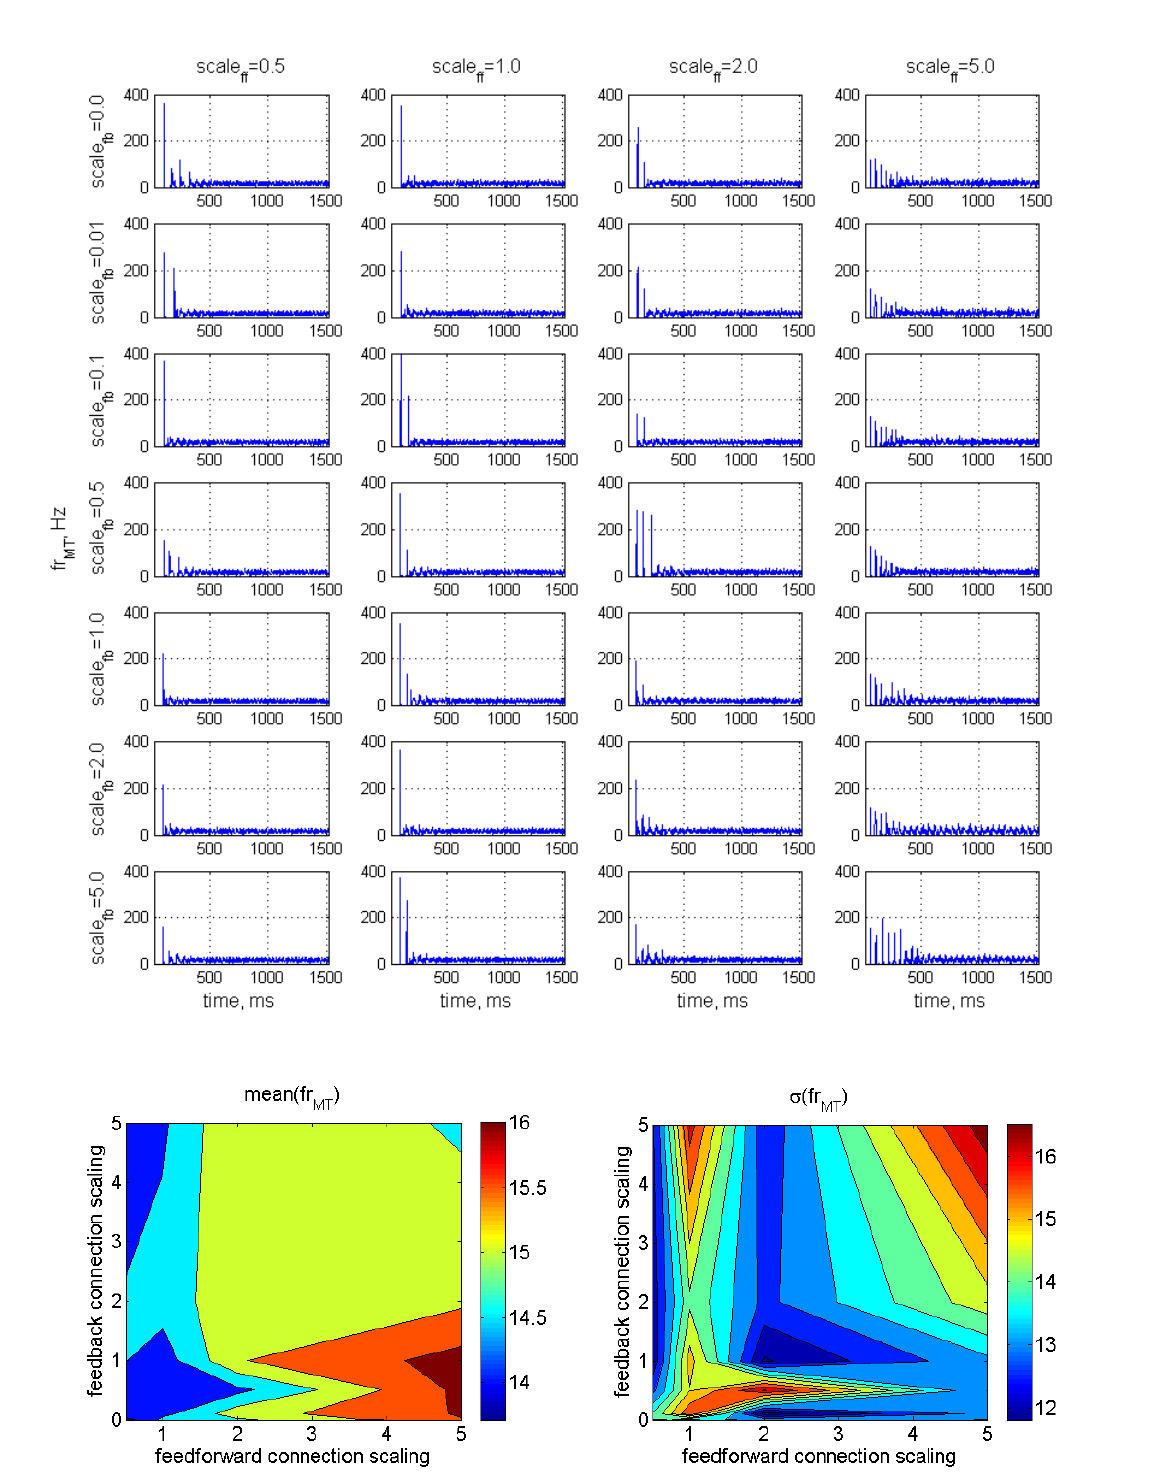
Fig. 5. Spiking activity in MT and its mean (bottom left) and variance (bottom right).